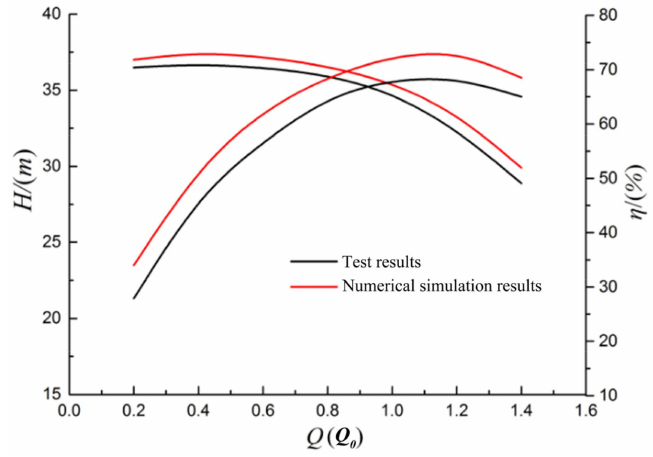
Figure 8. External characteristic curve of numerical simulation and test.